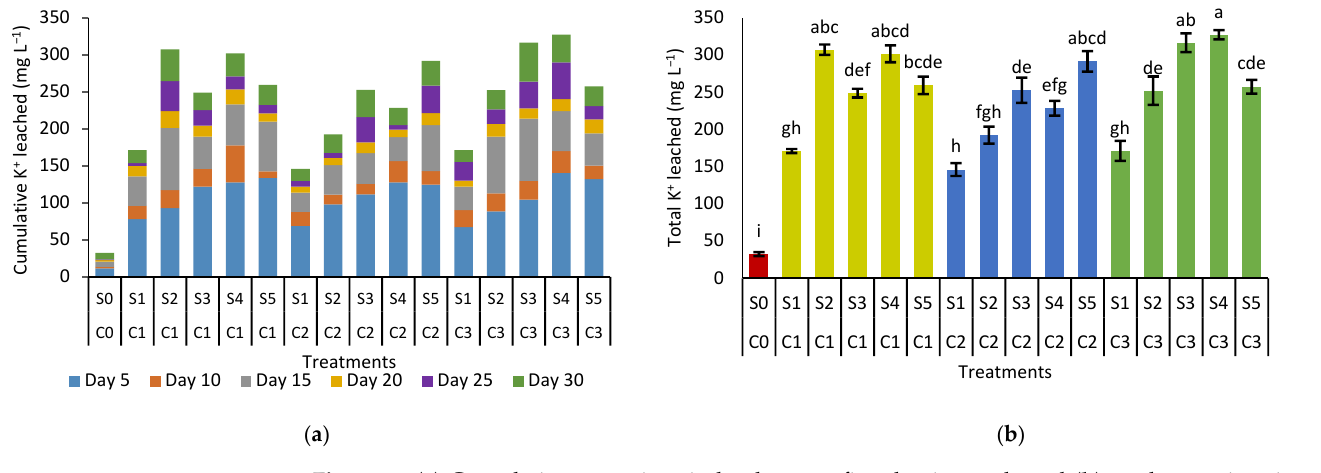
Figure 6. ( a ) Cumulative potassium in leachates at five day intervals and ( b ) total potassium in leachates for the different treatments after thirty days of leaching. Different letters indicate significant mean differences using Tukey’s HSD test at p ≤ 0.05. Error bars represent the standard error of the mean.